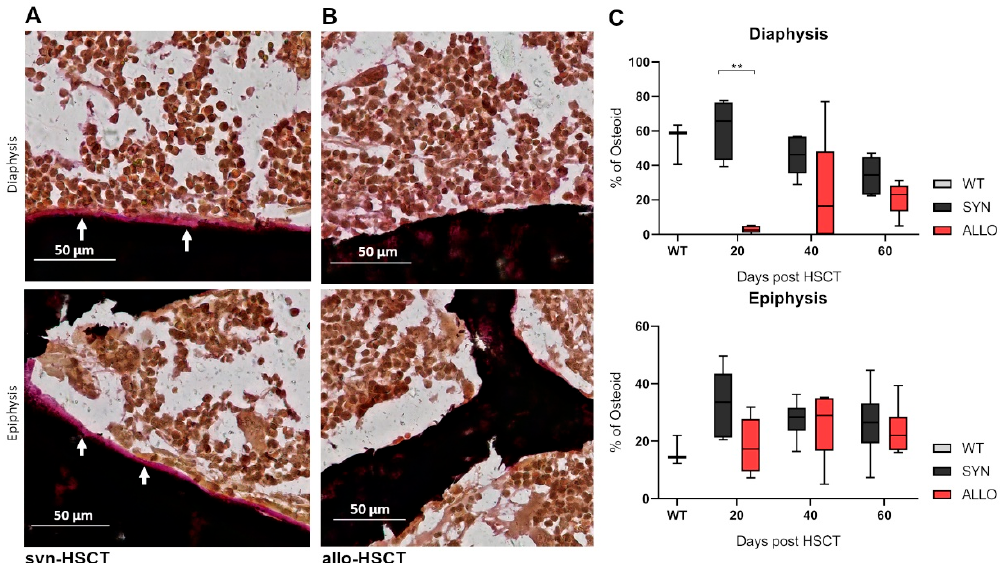
Figure 6. Representative images of femora of HSCT recipients after histological visualization by von Kossa and van Gieson staining (N = 3). Mineralized bone tissue (black), BM (orange-red) and osteoid (pink) are visualized. ( A ) Epiphyseal and Diaphyseal region of the femora from syn-HSCT recipients. ( B ) Epiphyseal and Diaphyseal region of the femora from allo-HSCT recipients. Scale bar = 50 µm. ( C ) Percentage of osteoid analyzed in the diaphyseal and epiphyseal region of femora (WT N = 3, syn N = 6, allo N = 6). ** p ≤ 0.01 by Mann-Whitney-U-Test.